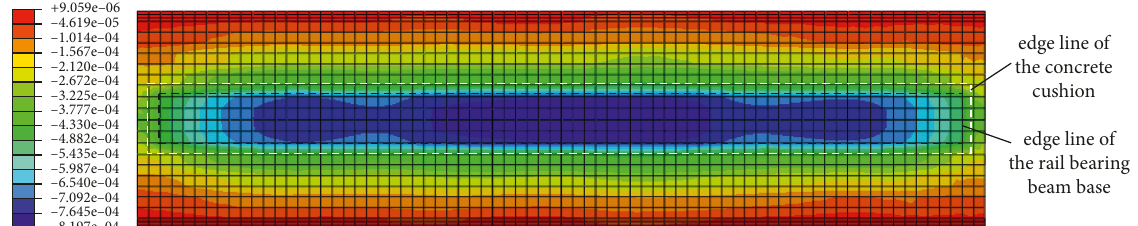
Figure 13: Deformation distribution cloud diagram of the surface of the foundation